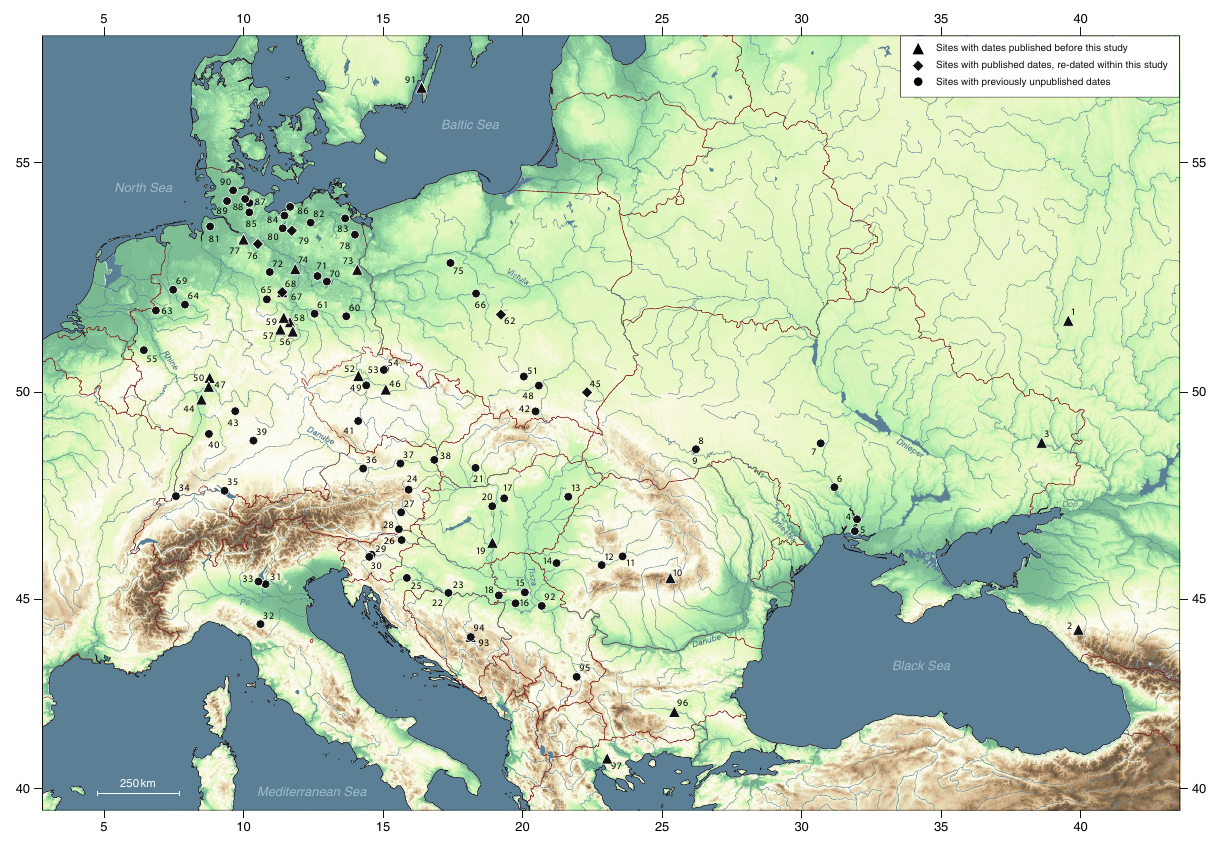
Figure 1. The location of sites in Europe with published and new broomcorn millet dates: (1) Rykan; (2) Guamsky Grot; (3) Zanovskoe; (4) Dikiy Sad; (5) Olbia; (6) Vinogradnyi Sad; (7) Maidanetske; (8) Zalissya; (9) Ivane-Puste; (10) Măgura-Buduiasca; (11) Teleac; (12) Miercurea-Sibiului; (13) Debrecen; (14) Corne ș ti; (15) Kalakača; (16) Gomolava; (17) Pécel; (18) Bosut; (19) Fajsz; (20) Százhalombatta; (21) Vráble; (22) Crišnjevi; (23) Oštrovi; (24) Gasteil; (25) Lasinja; (26) Orehova Vas; (27) Neudorf; (28) Retznei; (29) Dragomelj; (30) Tribuna; (31) Custoza; (32) Santa Giulia; (33) Lavagnone; (34) Binningen; (35) Hagnau; (36) Ansfelden; (37) Meidling; (38) Stillfried; (39) Ipf; (40) Knittlingen; (41) Pisek-Sever; (42) Maszkowice; (43) Königshofen; (44) Goddelau; (45) Lipnik; (46) Velim; (47) Fechenheim; (48) Witów; (49) Roztoky; (50) Bruchenbrücken; (51) Miechów; (52) Zahájí; (53) Valečov; (54) Soví převis; (55) Jülich-Güsten; (56) Schafstädt; (57) Niederröblingen; (58) Bösenburg; (59) Quenstedt; (60) Großbahren; (61) Radis; (62) Lutomiersk; (63) Borken; (64) Warendorf; (65) Watenstedt; (66) Szczepidło; (67) Hundisburg; (68) Olbetal; (69) Altenrheine; (70) Potsdam; (71) Möthlow; (72) Lüdelsen; (73) Rathsdorf; (74) Walsleben; (75) Smuszewo; (76) Rullstorf; (77) Hittfeld; (78) Pasewalk; (79) Badegow; (80) Schwerin; (81) Flögeln; (82) Vogelsang; (83) Butzow; (84) Wismar; (85) Wahlstedt; (86) Zweedorf; (87) Depenau; (88) Flintbek; (89) Borgstedt; (90) Brekendorf; (91) Risinge; (92) Starčevo; (93) Okolište; (94) Donje Moštre; (95) Hisar; (96) Yabalkovo; (97) Assiros.[Map generated using the software: QGIS 3.10.5—A Coruña (https ://qgis.org); copyright by OpenStreetMap contributors, terrestris GmbH & Co KG (https ://www.terre stris .de), and Natural Earth Data (https ://www.natur alear thdat